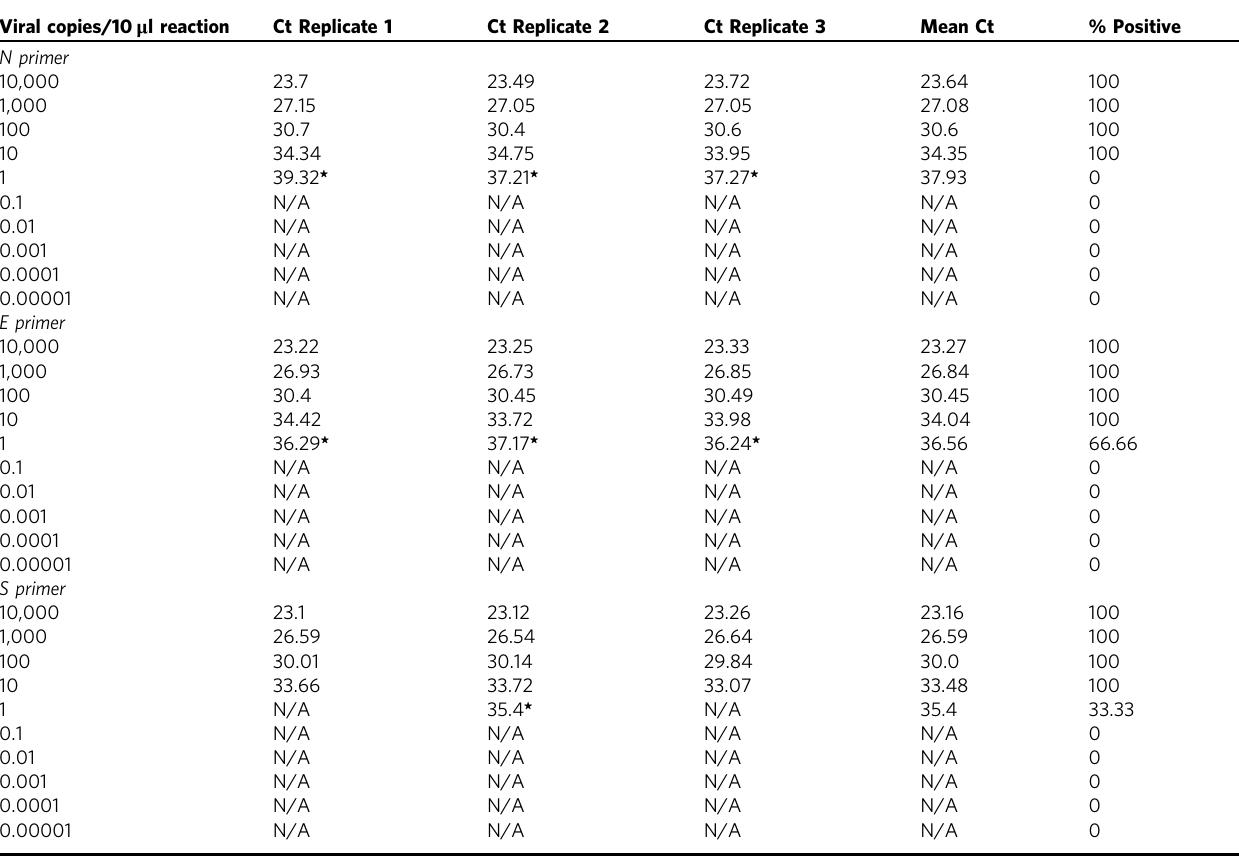
Table 1 Estimation of the limit of detection